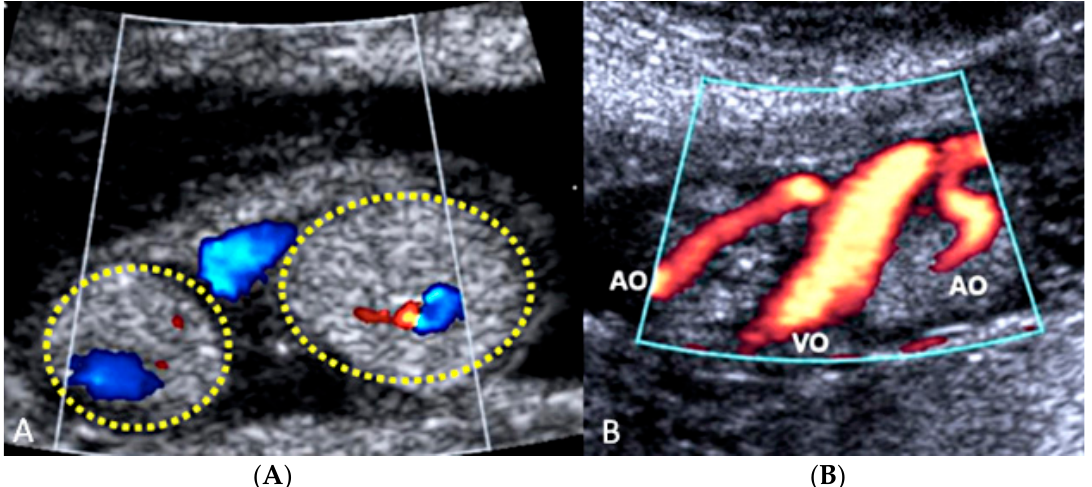
Figure 26. Sonographic evaluation of umbilical cord hemangioma. (Legend: AO: umbilical artery; VO: umbilical vein). Umbilical cord hemangioma or angiomyxoma is usually located in the terminal portion of the cord on the placental side. Two-dimensional color ( A ) and power Doppler ultrasound ( B ) may detect a fusiform or saccular swelling of the umbilical cord. Umbilical arteries are sur- rounded by a particularly echogenic material arranged as a sheath of the same vessels. The mechan- ical compression of the umbilical circulation may be determined by an enlargement of the mass and stenosis of the umbilical vessels also caused by the intraluminal proliferation of the hemangioma. Blood flow reduction can be abruptly compromised through the twisting of the cord favored by the mass and by the presence of pseudocysts. An accurate follow-up is mandatory.